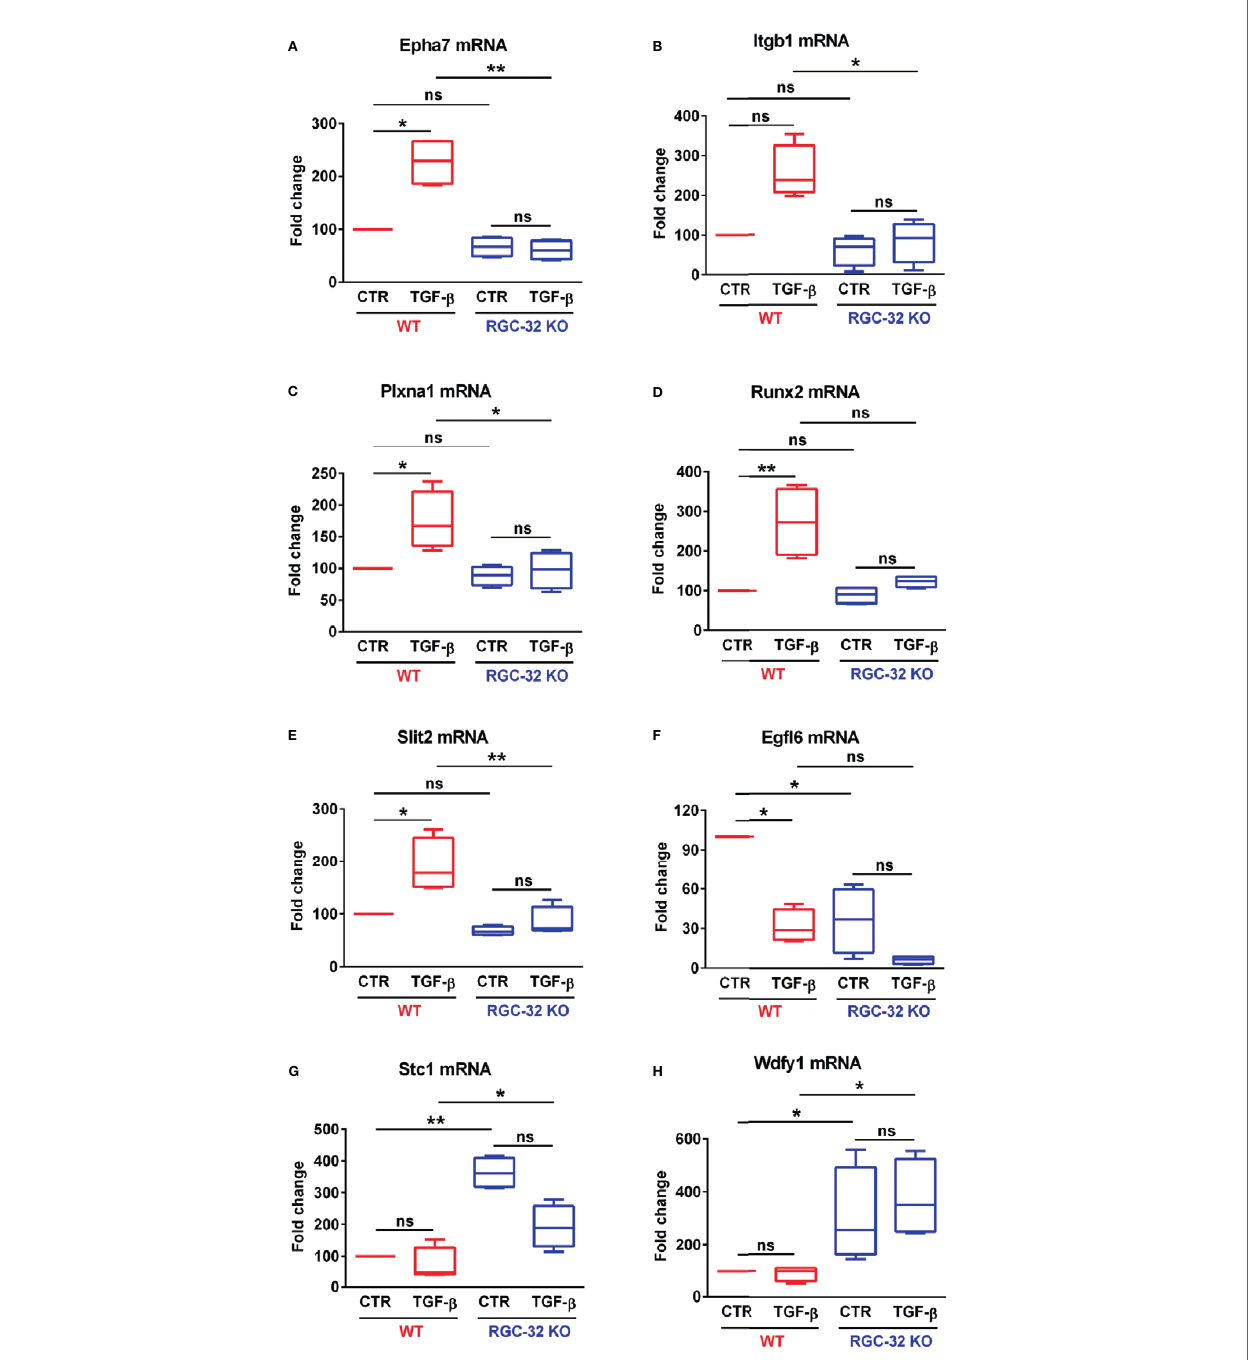
FIGURE 5 | RGC-32 regulates the expression of genes associated with brain development. WT and RGC-32 KO mouse astrocytes were treated with 10 ng/ml TGF- b for 24 h and then analyzed by Real-Time PCR. Epha7 (A) , Plxna1 (C) , Runx2 (D) , and Slit2 (E) were signi fi cantly up-regulated in WT astrocytes but not in RGC-32 KO astrocytes. There was also a clear trend toward upregulation of Itgb1 levels in WT astrocytes after stimulation, although this result did not reach statistical signi fi cance (B) . Nevertheless, Itgb1 ’ s induced levels were signi fi cantly higher in WT astrocytes than in RGC-32 KO astrocytes (B) . Eg fl 6 was signi fi cantly higher in unstimulated WT astrocytes when compared to their RGC-32 KO counterparts, and its expression was signi fi cantly down-regulated in WT astrocytes after TGF- b stimulation (F) . On the other hand, Stc1 (G) and Wdfy1 (H) levels were signi fi cantly higher in RGC-32 KO astrocytes under both basal and stimulated conditions. The expression of the mRNA in unstimulated (CTR) WT astrocytes was considered to be 100, and the results are shown as -fold change. Data are expressed as mean ± SEM (N = 4). *p < 0.05; **p < 0.01; ns, not statistically signi fi cant (Kruskall-Wallis test with Dunn ’ s multiple comparisons